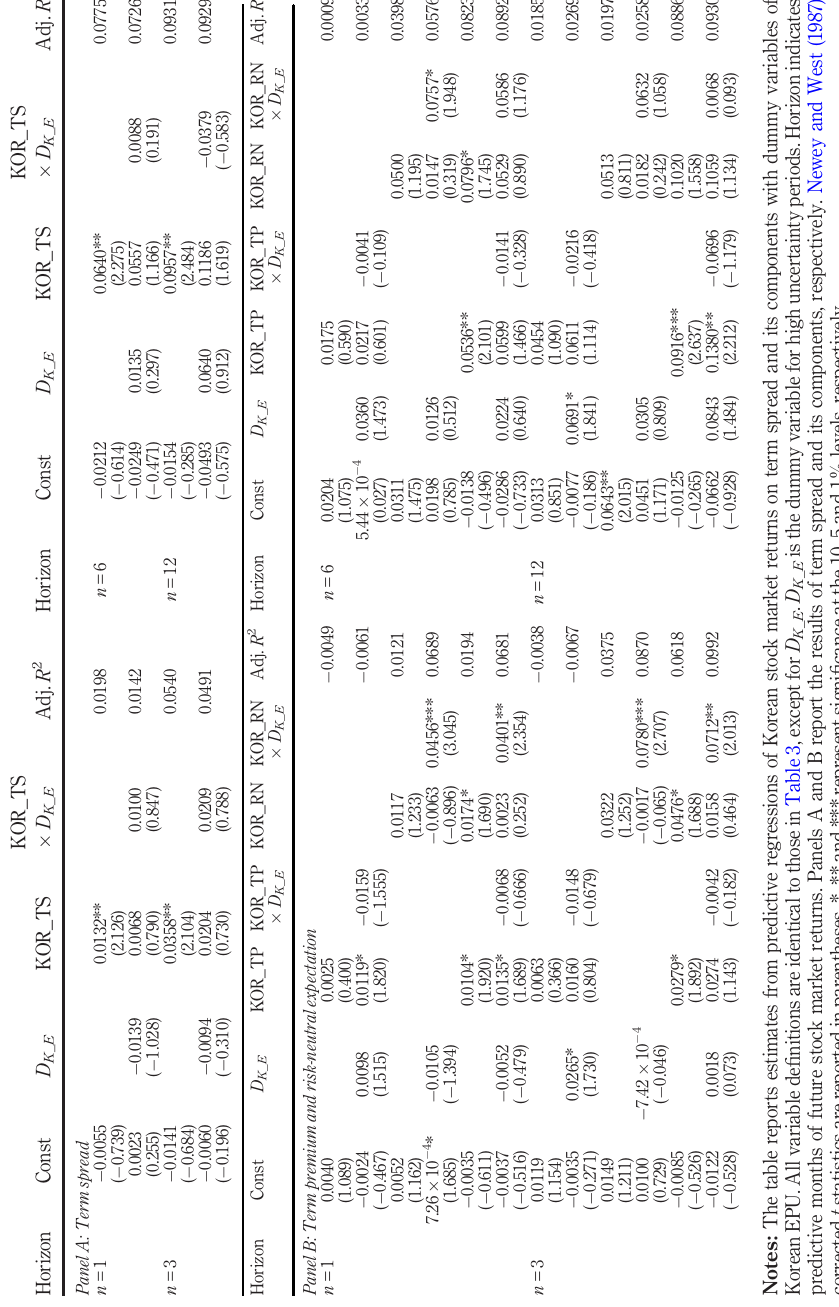
Table 4. Information of term spread and its components with uncertainty in Korean stock